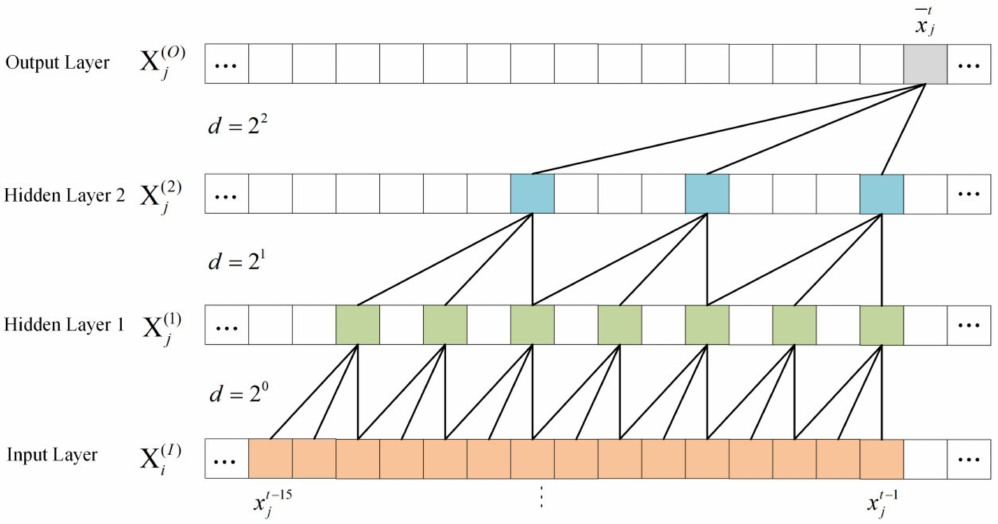
Figure 6. Single-channel depthwise convolution.